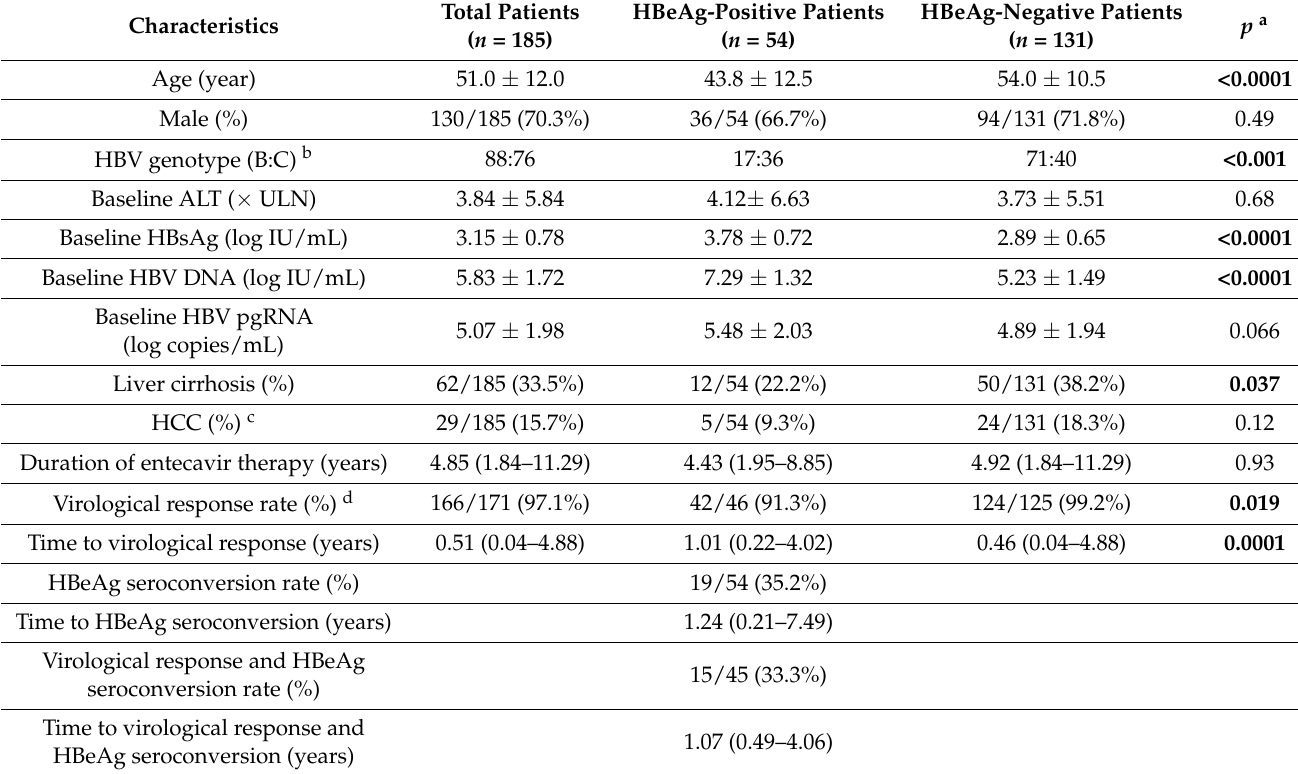
Table 1. Clinical characteristics of 185 patients with chronic hepatitis B for studying the kinetics of serum HBV pgRNA during entecavir therapy, categorized by HBeAg